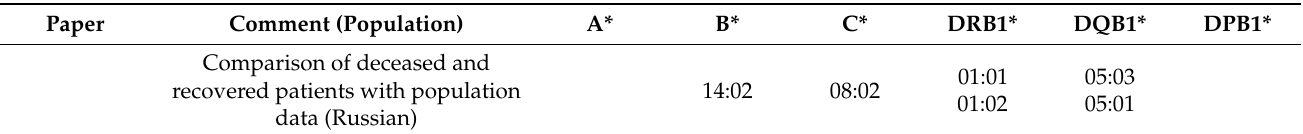
Table 22. Comparison of the obtained alleles in the context of COVID-19 based on the pertinent liter-